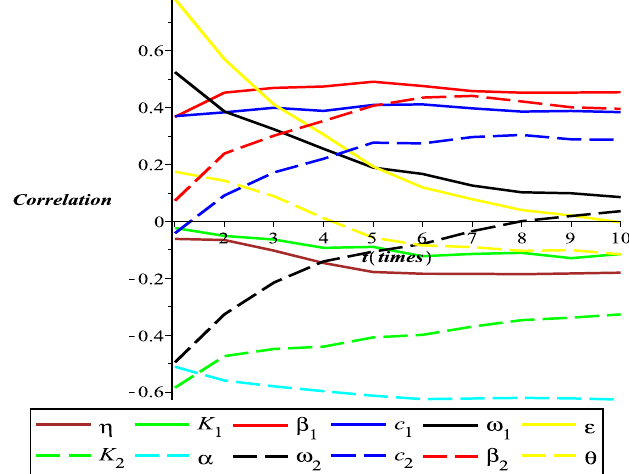
Figure 8. The bar chart for PRCC of the infectious population treated at home at t = 10.